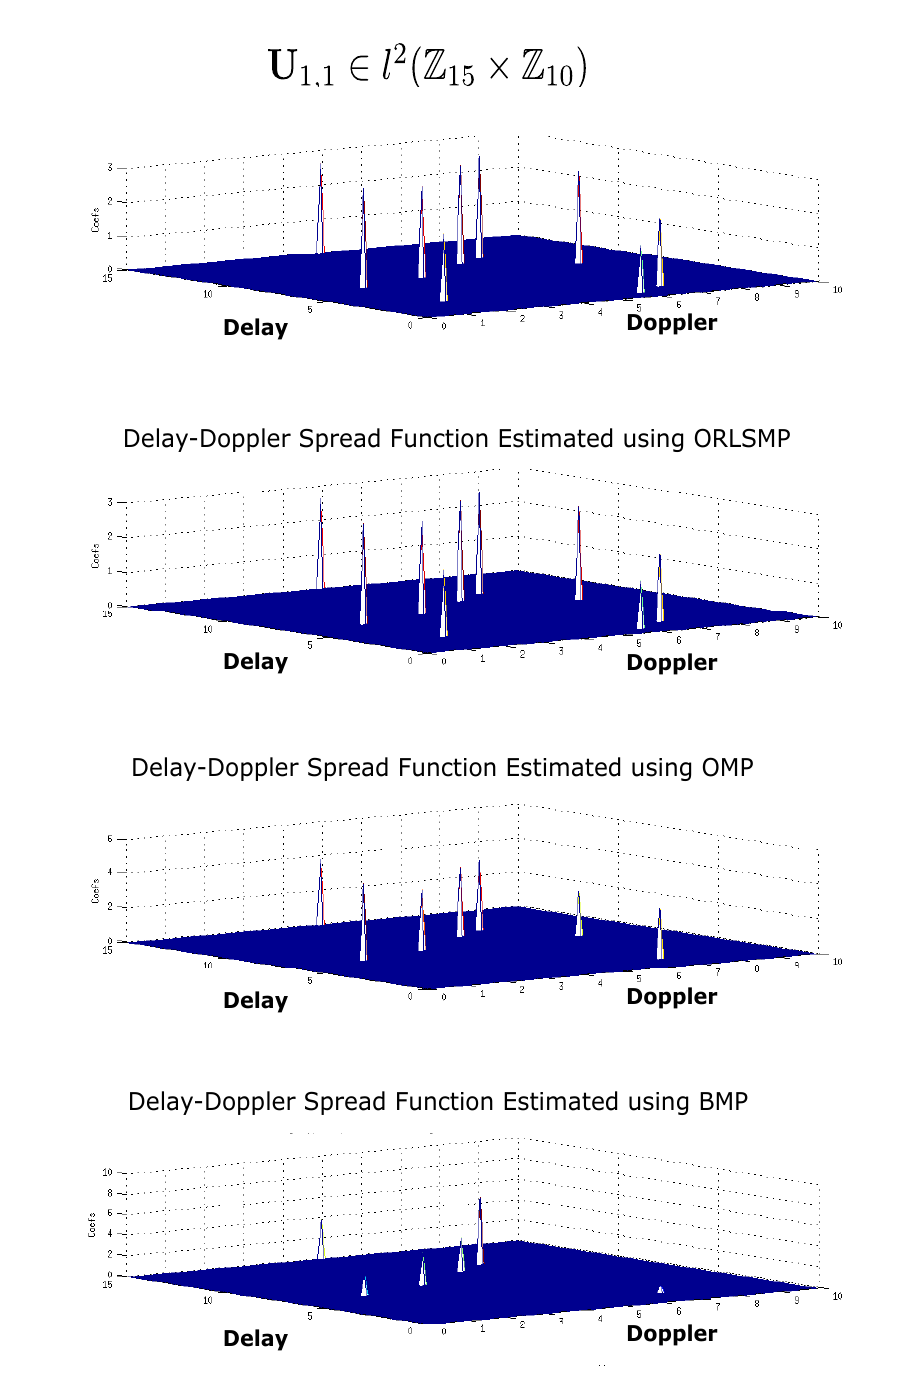
Figure 9. MIMO (2 × 2). Delay-Doppler spread function U 1,1